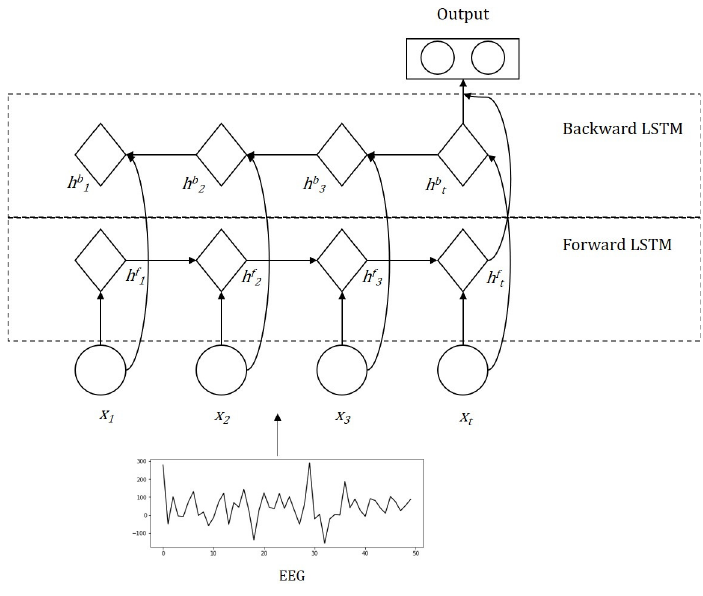
Figure 6. Example of EEG-based emotion detection by using